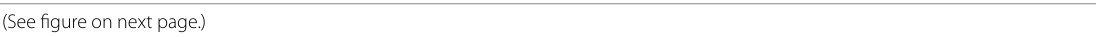
events(See figure on next Fig. 8 Superposed epoch analysis of electron auroral and proton auroral variations. The time ( x axis) used in this plot is normalized according to Eq. (1) in the text. a The variations of electron aurora arc inferred from THEMIS or MSP 557.7 nm observations in 12 substorm events. b The proton auroral variations inferred from FESO/MSP, in the same arc band as the electron aurora. Note in ( a ) and ( b ) a shaded region indicates that the sampled intensity may no longer represent preexisting arc after T 1. c Total proton auroral intensities integrated over the FESO/MSP latitudes. In ( d ) and ( e ), we show the percentage variations of the arc band proton auroral intensity and the total proton auroral intensity, relative to their mean late growth phase values (see text for details). The scan time of FESO/MSP is marked by a horizontal bar. Different colors in this figure denote different